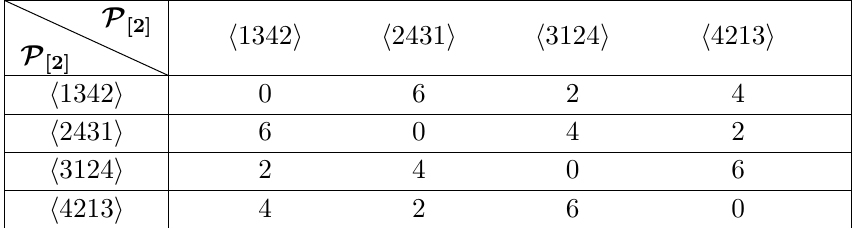
Table 2. { TM } − { TM } two-point correlator